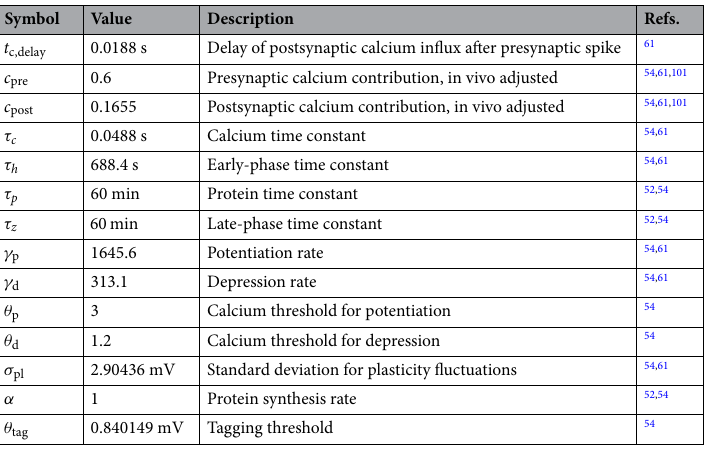
Table 2. Parameters for synaptic plasticity. Values were used as given in this table, unless stated